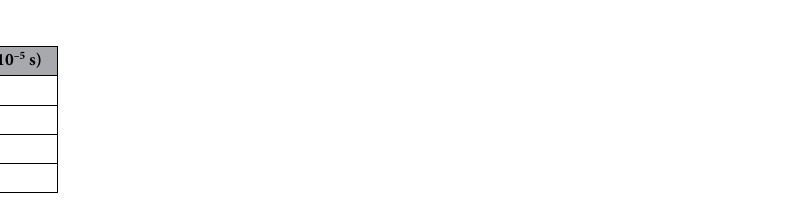
Table 6. Relaxation time for PUA-30 wt% TBAI-I 2 GPE system at selected temperatures.